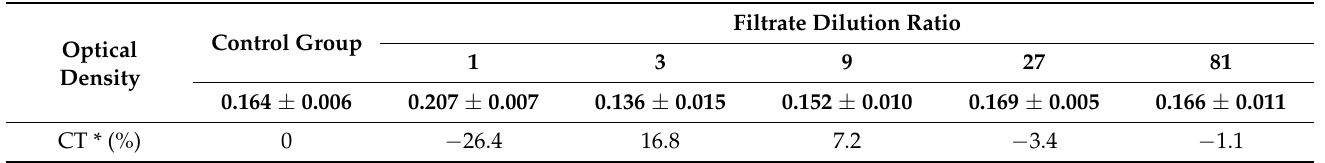
Table 1. Change in the optical density of the alga Chlorella vulgaris Beijer when exposed in the filtrate